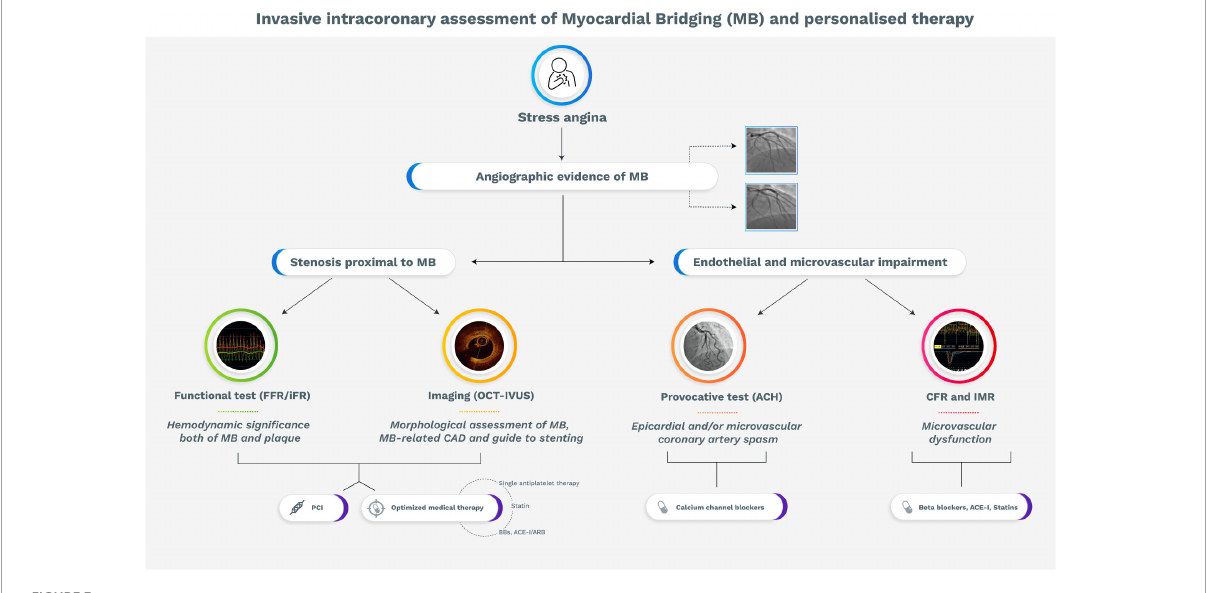
FIGURE3 Flow diagram with proposed strategy for the management of symptomatic patients with myocardial bridging. ACE-I, Angiotensin-converting enzyme-inhibitors; Ach, acetylcholine; ARB, Angiotensin receptor blocker; BBs, beta-blockers; CAD, coronary artery disease; CFR, coronary flow reserve; FFR, fractional flow reserve; iFR, instantaneous wave-free ratio; IMR, index of microvascular resistance IVUS, intravascular ultrasound; MB, myocardial bridging; OCT, optical coherence tomography; PCI, percutaneous coronary